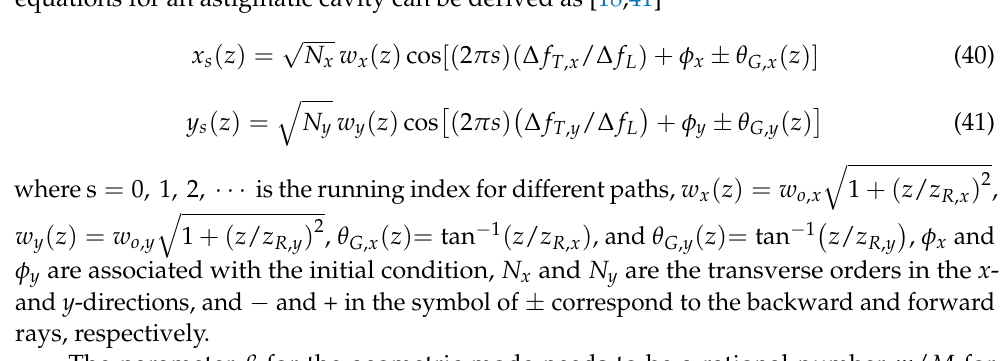
(cid:1) (cid:0) z / z R , y , φ x and